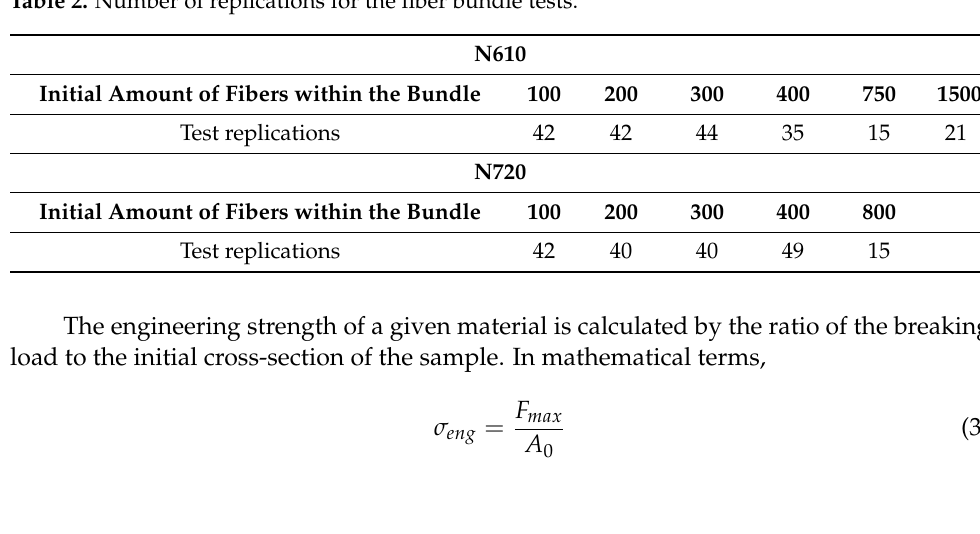
Table 2. Number of replications for the fiber bundle